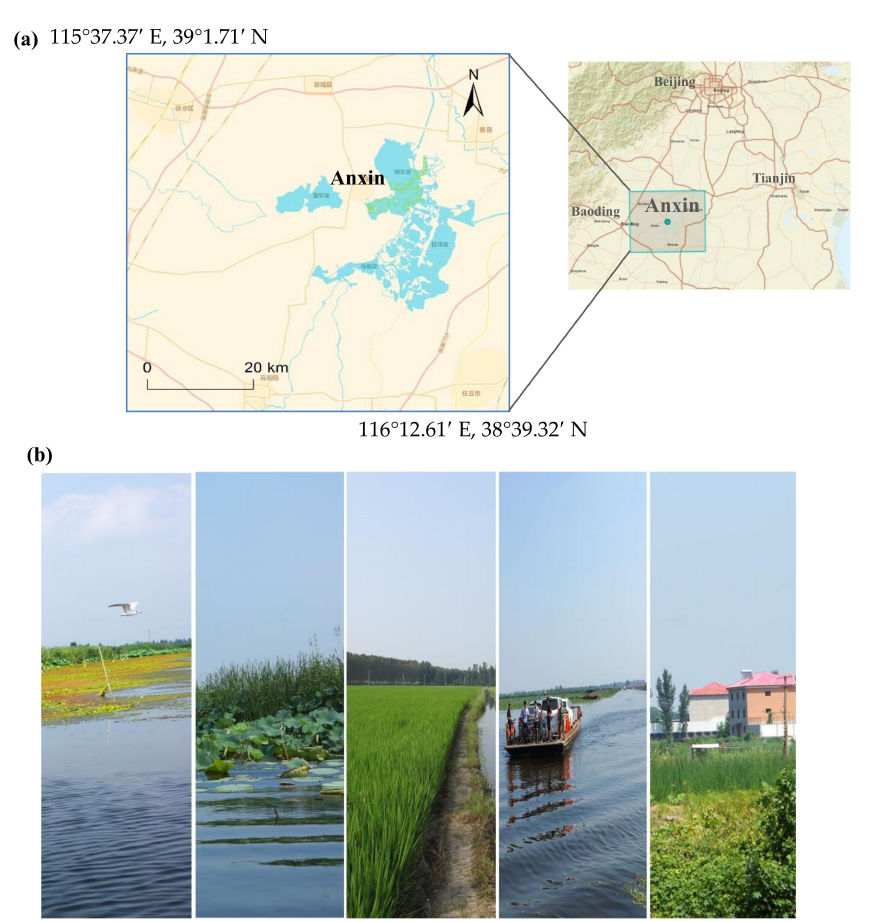
Figure 1. Overview of the study area where ( a ) is the location of Baiyangdian wetland and ( b ) show typical natural and manmade landscapes in the wetland, that is floating vegetation and open water in the first column, emergent vegetation of reeds, cattails and lotus, and open water in the second column, paddy and trees in the third column, water tra ffi c in the fourth column, and residential houses and cropping in the last column from the left to right photos,